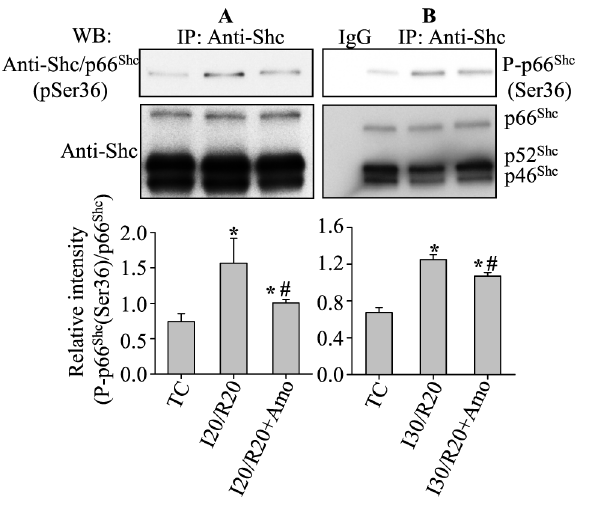
Figure 5. IR-induced phosphorylation (P) of p66 Shc at Ser36 was decreased by amobarbital (Amo) after 20 (A) or 30 (B) min ischemia (I) followed by 20 min reperfusion (R). A , B , upper panel: phosphorylation of p66 Shc at Ser36; equal amounts of p66 Shc loading were verified with anti-ShC antibody ( A , B : middle panel). Summary of mean band intensities derived from three independent experiments (n 5 3 hearts/group) ( A , B : lower panel). IP, immunoprecipitation; TC, time controls (no IR). P , 0.05: *IR vs. TC; # Amo + IR vs.